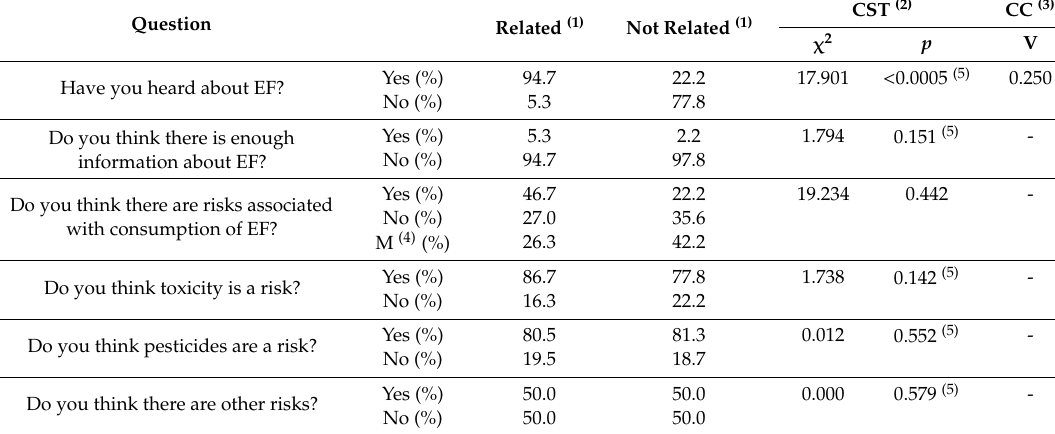
Table 4. Information about edible flowers (EF), according to professional areas in Portugal and Costa Rica (considered